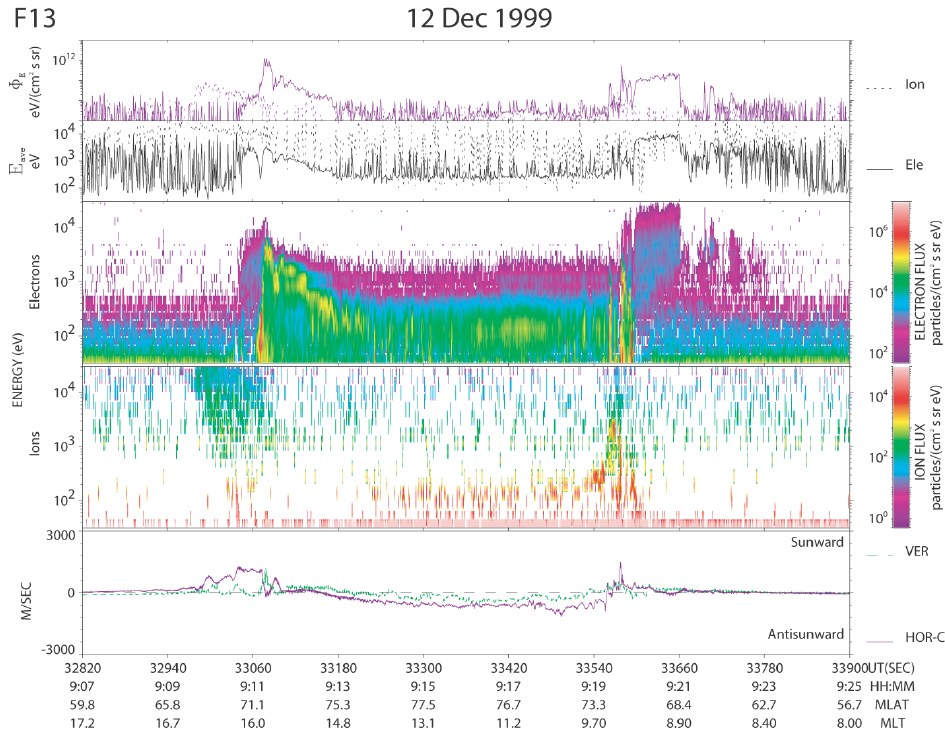
Figure 21 Fig. 21. Particle spectrograms and ionospheric ion drift obtained from spacecraft DMSP F13 during the interval 09:07–09:25 UT on 12 De- cember 1999. Panels 1 and 2 show differential energy flux for electrons (solid) and ions (dashed) and average energy, respectively. Panels 3 and 4 show color coded particle-spectrograms for electrons and ions, respectively. Panel 5 show ion drift in the horizontal (cross track; violet) and vertical (upward; green)